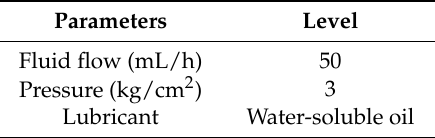
Table 6. Analysis of variance for surface roughness.